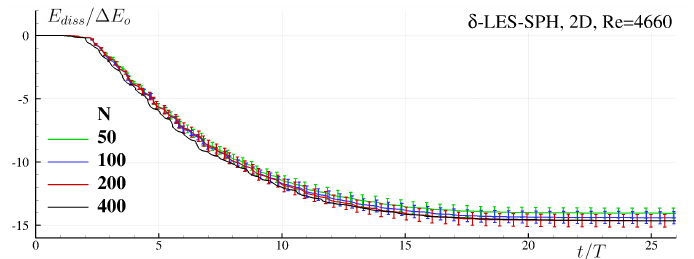
Figure 7. Test with oil: ensemble average of the energy dissipation E diss time history for different spatial resolutions N = 50, 100, 200. Error bars refer to the computed standard deviation. Resolution N = 400, the data refers to a single simulation.